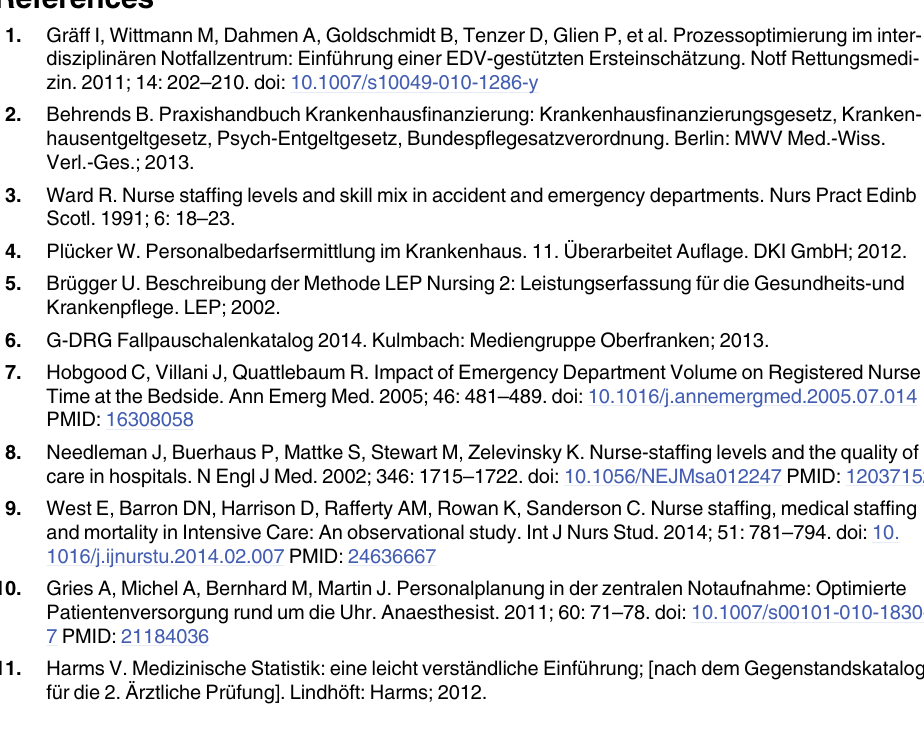
S2 Fig. Empirical distribution function. Exemplary illustration of an empirical distribution function for the period on Mondays between12:00 a.m. - 12:59 a.m. Accordingly, in order to, for example, have sufficient staff in 85% of cases in this period (85% percentile); it is necessary to have 126 minutes of staff time available. S1 Table. Main features of emergency care at the University Hospital Bonn. S2 Table. Definition of the performance variables. S3 Table. Number of patient arrivals (exemplary record). An example of a record for Mon- day 12:00 a.m. - 12:59 a.m. with the number of patients in the respective MTS categories. S4 Table. Confidence intervals. Confidence intervals were evaluated by non-parametric boot- strapping (10000 bootstrap samples per confidence interval). S5 Table. Staff shortfall times in the interdisciplinary emergency department (cid:4) .